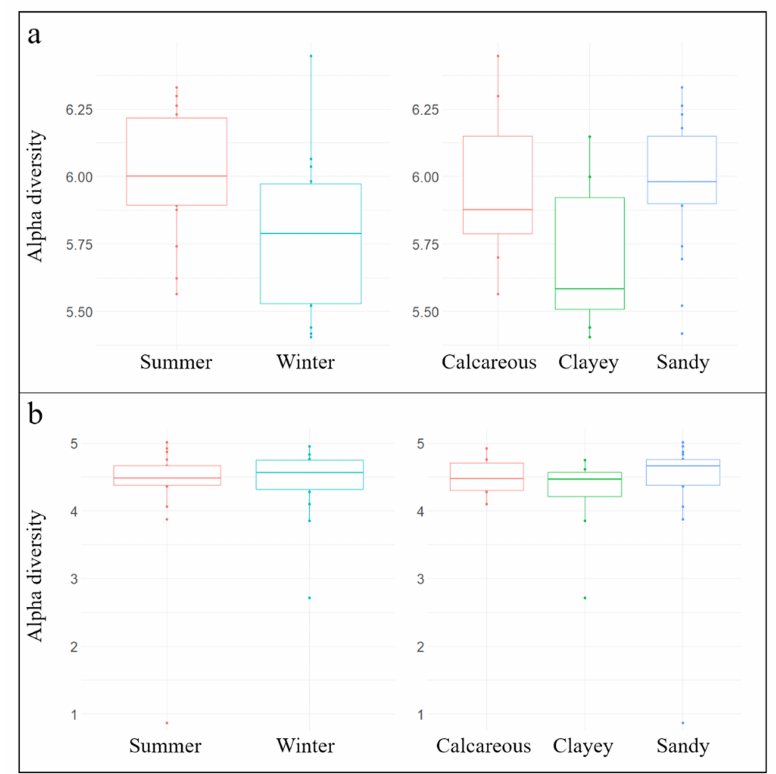
Figure 1. Alpha diversity, measured as Shannon index, calculated on bacterial subset of the dataset ( a ) showed significant differences ( p -value = 0.012) among seasons, but not among soil types ( p -value = 0.056). When alpha diversity was calculated on the fungal subset of the dataset ( b ), no statistically significant differences were found for seasons ( p -value = 0.716) and for soil type ( p -value =